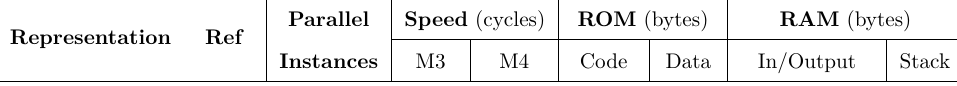
Table 2: Implementation results on ARM Cortex-M3 and M4 for various bitsliced repre- sentations of AES . For encryption routines, speed is expressed in cycles per block and the RAM requirements for the round keys are enclosed in parentheses. Emboldened and italic fonts refer to unrolled and non-unrolled implementations,